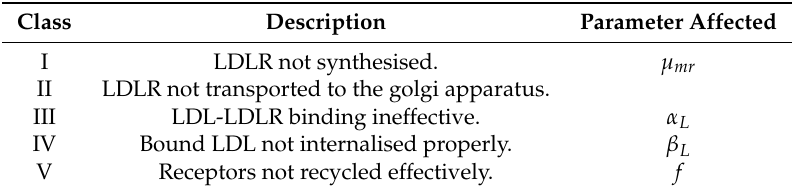
Table 3. Familial hypercholesterolaemia class types and their relation to parameters in our model. Class Description Parameter